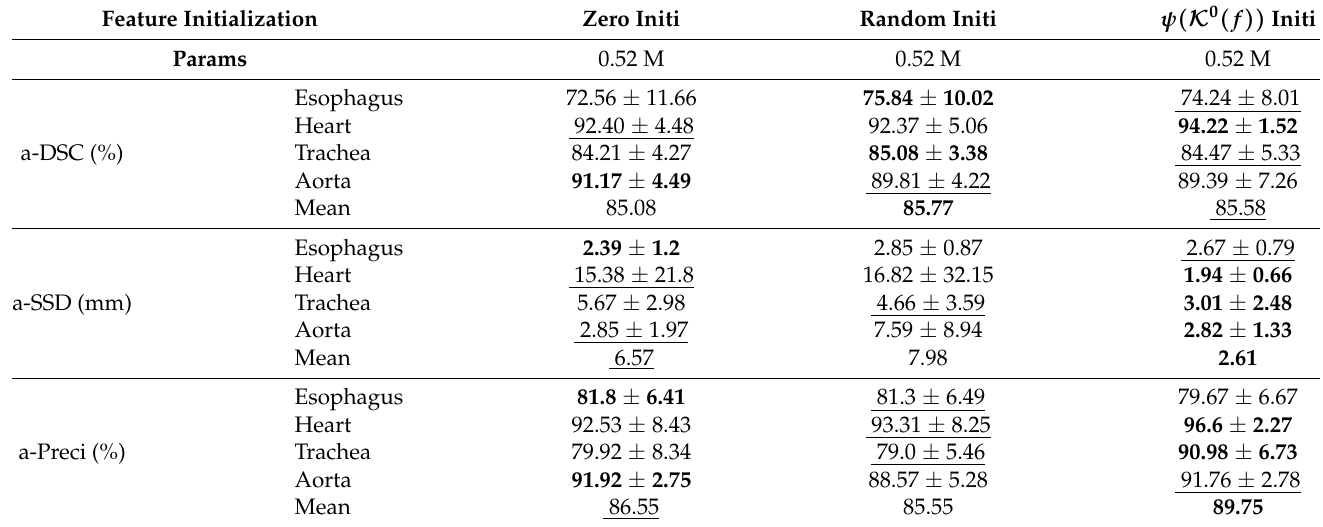
Table 3. Quantitative assessment with the a-DSC, a-SSD, and a-Preci values of different initialization techniques (zero initialization, random initialization, and feature extraction initialization ψ ( K 0 ( f ))) using the proposed 2D FAS-UNet framework on the 2D SegTHOR validation datasets with four organs: esophagus, heart, trachea, and aorta. “Mean” denotes an average score segmenting all organs. The best and second places are highlighted in bold font and underlined, respectively.